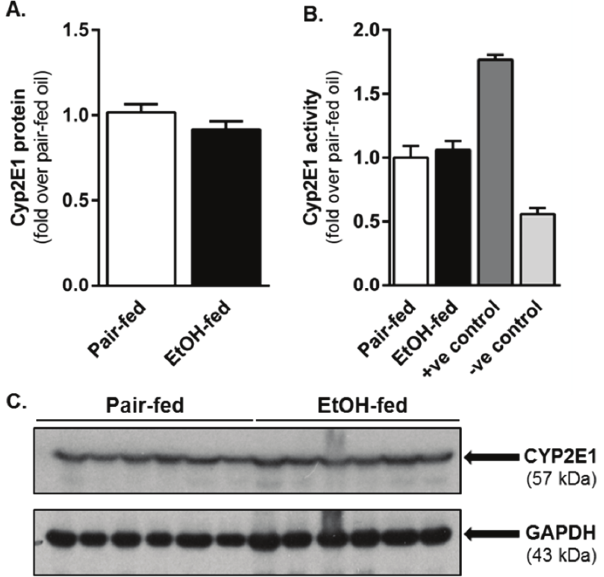
Figure 1. Hepatic CYP2E1 content and activity did not differ between control (pair-fed) or ethanol-fed mice. Mice were allowed free-access to a 2% ( v / v ) ethanol-containing Lieber-DiCarli diet, or pair-fed a control diet, for 10 days. Livers were harvested, a portion of which was used for performing a CYP2E1 immunoblot ( A , C ) while a separate portion was used to perform a CYP2E1 activity assay ( B ). In ( B ), the positive (+ve) control was generated by using microsomes isolated from mice fed a 5% ( v / v ) ethanol-containing diet for four weeks. The negative ( ´ ve) control was generated by using microsomes isolated from mice 24 h after a single CCl 4 exposure (CCl 4 consumptively depletes CYP2E1). N = 4–8 mice per group.